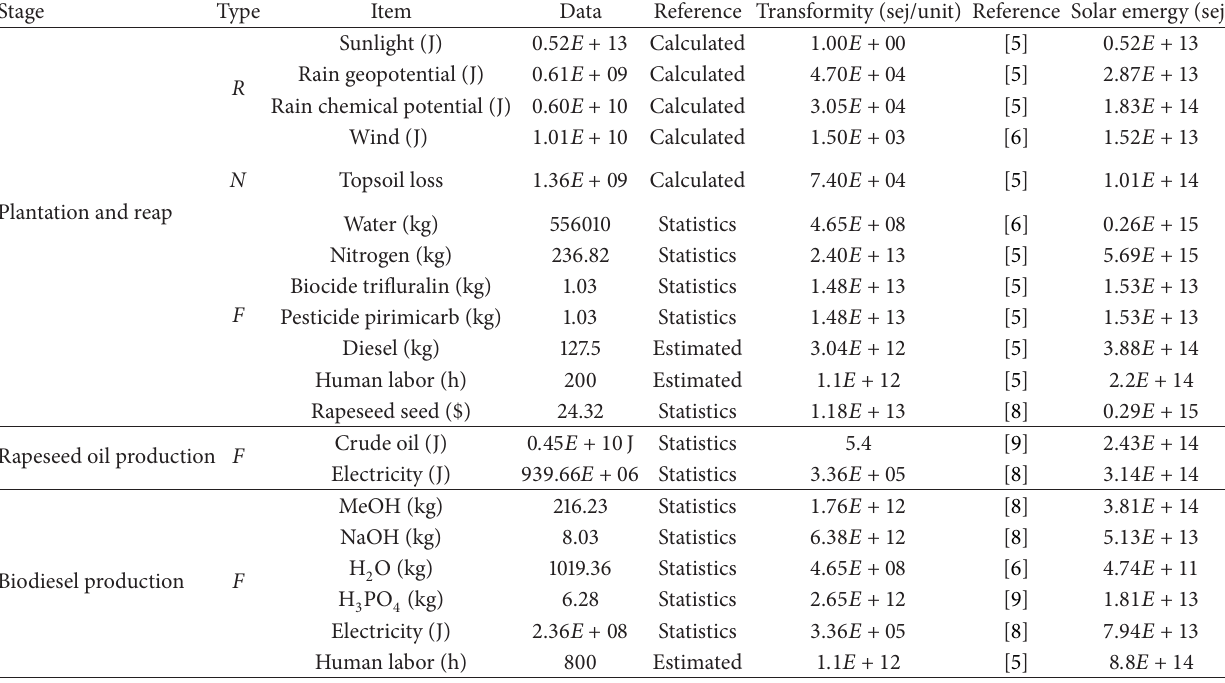
Table 4: Emergy analysis table for rapeseed-based